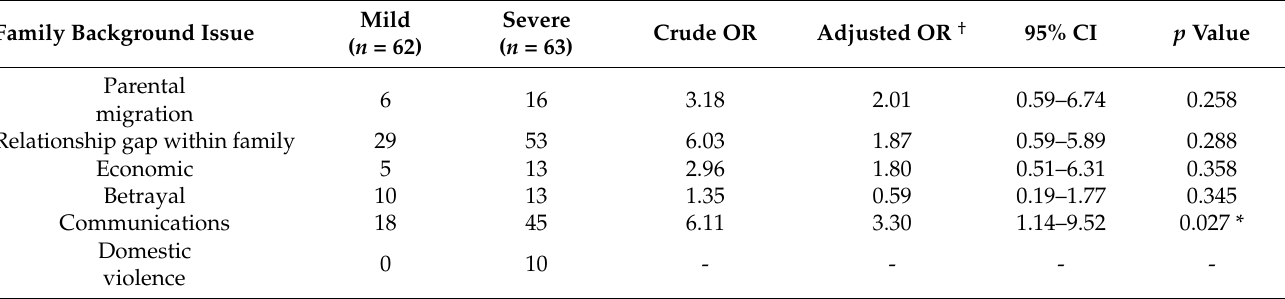
Table 3. Adjusted odds ratio for severe mental health problem associations with family background issues.